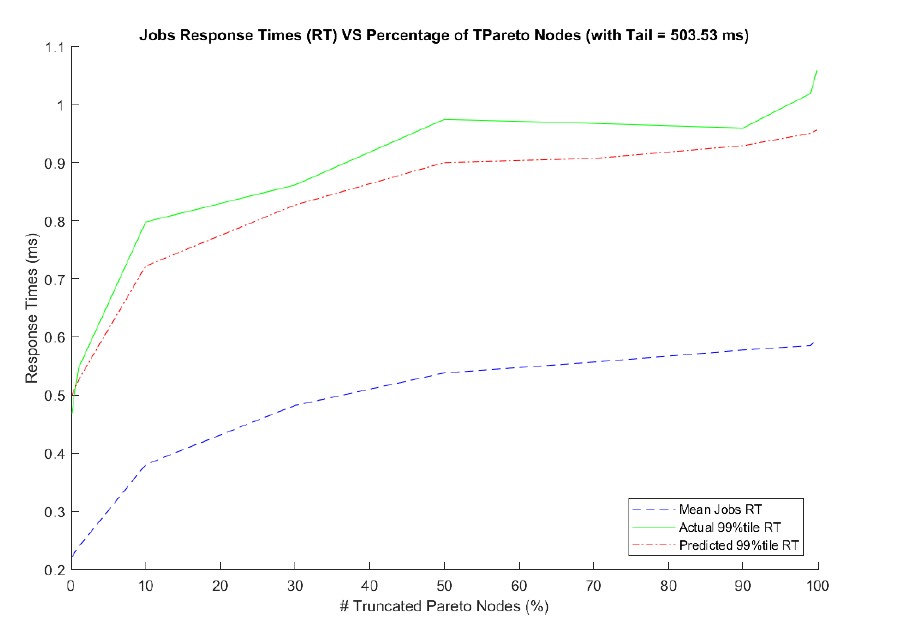
Figure 6. Job response times (RTs) against the increased percentage of inhomogeneous nodes (bounded Pareto with tail = 503.53 ms, and total cluster size = 900